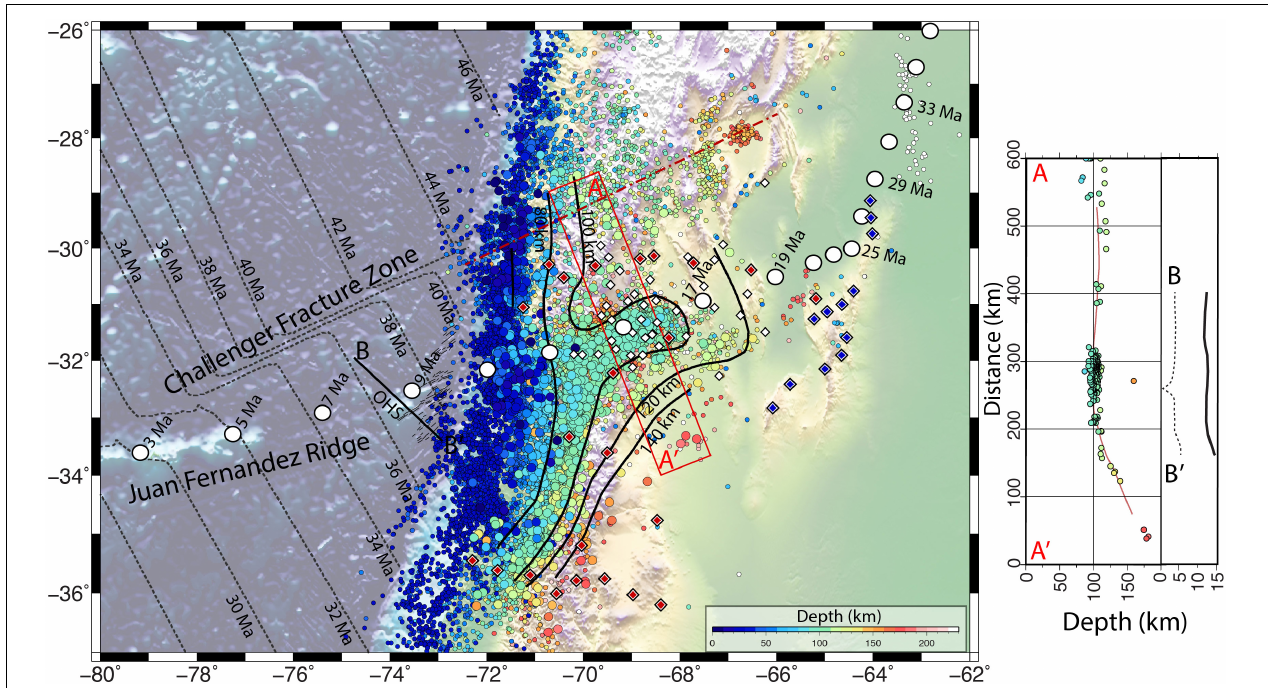
FIGURE 3 | Juan Fernandez Ridge subduction and earthquake distribution. Left: Map showing seismicity from the Reviewed International Seismological Center’s earthquake catalog (1990–2017), with events shallower than 50 km removed east of –70 ◦ W for clarity. Large circles are hypocenters from Anderson et al. (2007) also with hypocenters shallower than 50 km removed east of –70 ◦ W. Offshore dashed lines show age contours from Mueller et al. (2008). Offshore solid black line shows the location panel B,B (cid:48) of the cross section from Kopp et al. (2004). Label “OHS” indicates the location of the O’Higgins seamount. Thin black lines offshore near the OHS indicate the locations of ridge-parallel normal faults from Ranero et al. (2005). White circles show projected track of the Juan Fernandez Ridge, along with ages of the seamount at those locations, from Yañez et al. (2001). Red diamonds, blue diamonds, and white diamonds show seismic station locations for the CHARGE, ESP, and SIEMBRA experiments, respectively. Dash-dot red line shows projected location of Challenger Fracture Zone. Solid black lines show slab contours from Anderson et al. (2007). Red rectangular box panel A,A (cid:48) shows area over which events were projected onto cross section to the right. Right: Cross-section panel A,A (cid:48) across the projected location of the subducted Juan Fernandez Ridge. Circles show event locations (depth in km) from Anderson et al. (2007), and red line shows top of slab from Anderson et al. (2007). Right panel (B,B (cid:48) ) shows depth below sea level in km for the oceanic Moho (solid black line) and bathymetry (dotted line) across the O’Higgins seamount from Kopp et al.